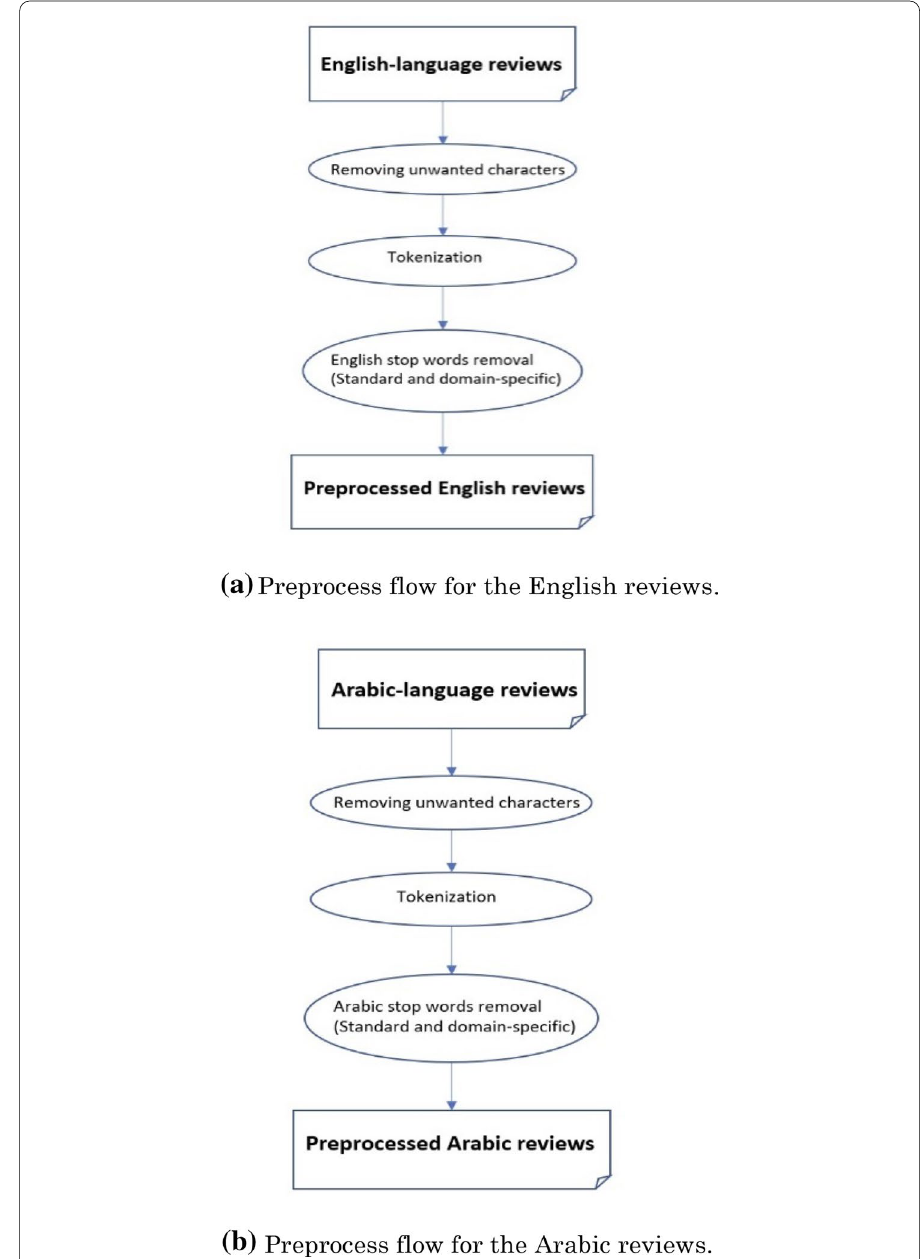
Fig. 3 Preprocessing scheme for the used English and Arabic